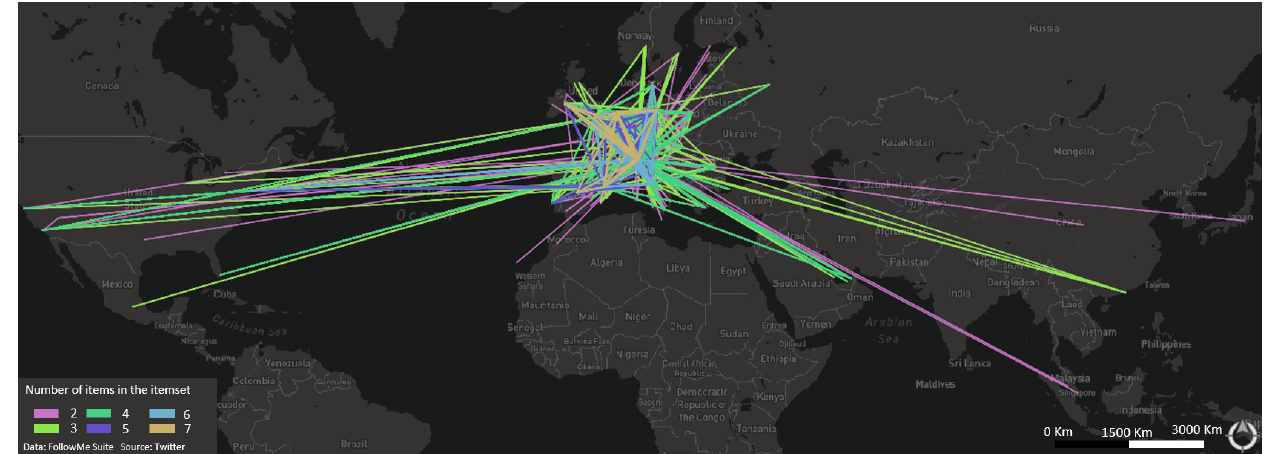
Figure 15. Topographic representation for discovered itemsets from the large data set by applying Interpretation 1.